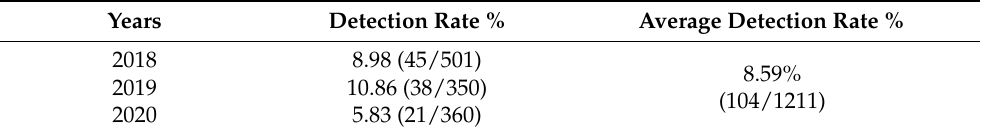
Table 2. Detection of antibiotics from 2018 to